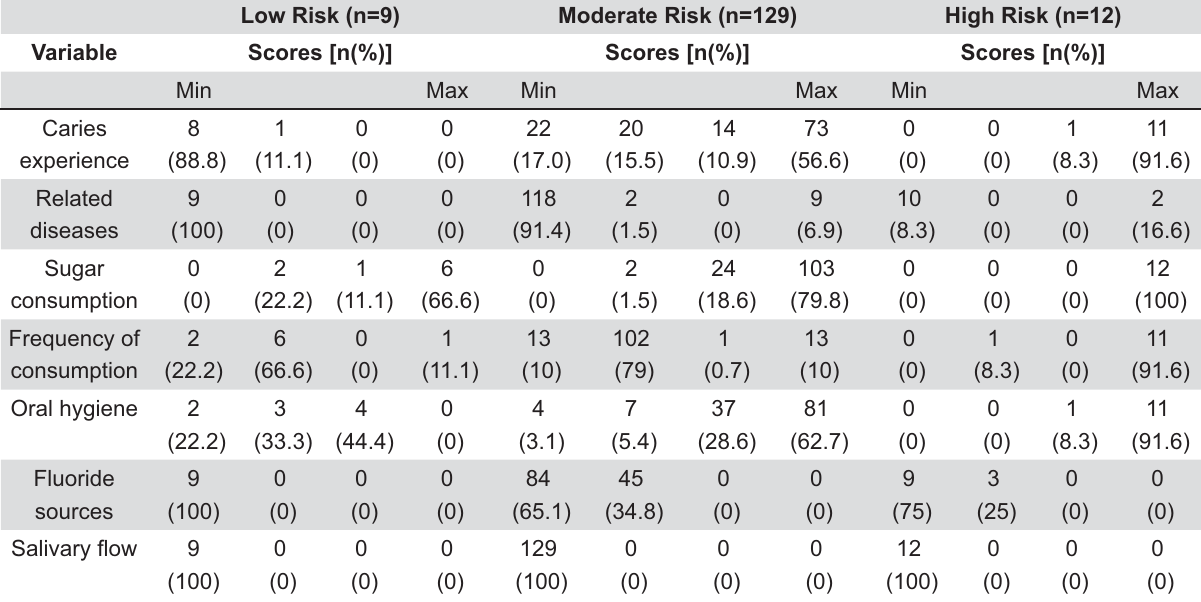
Table 2- Distribution of variables scores occurrence according to caries risk assessed